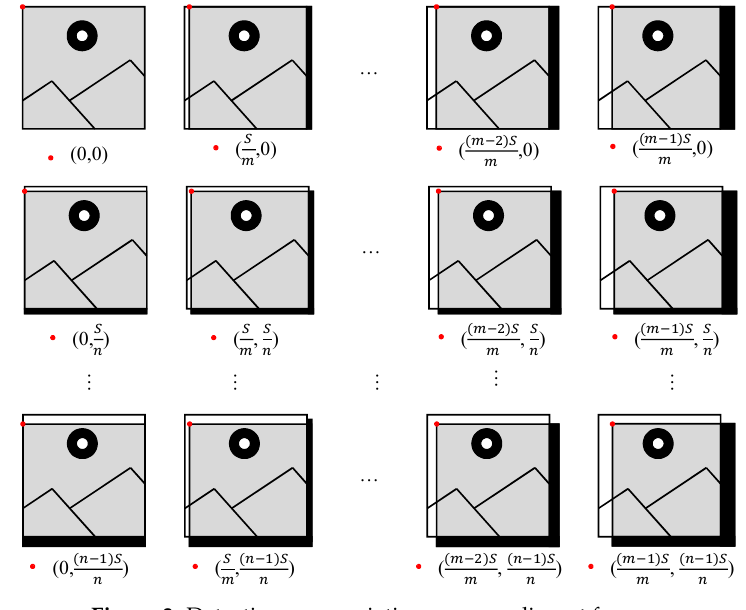
Figure 3. Detection area variation among adjacent frames.